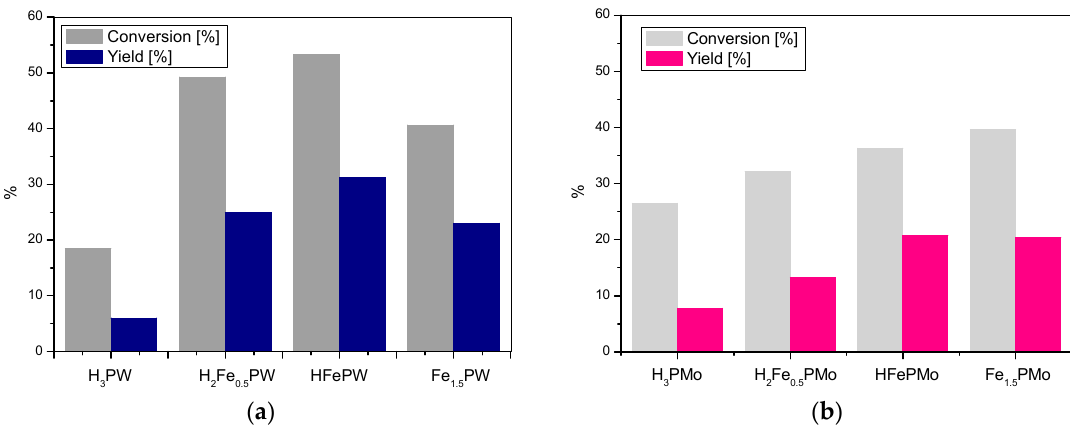
Figure 3. The BV oxidation of cyclohexanone with ( a ) iron tungstophosphate catalysts and ( b ) iron molybdophosphate catalysts.